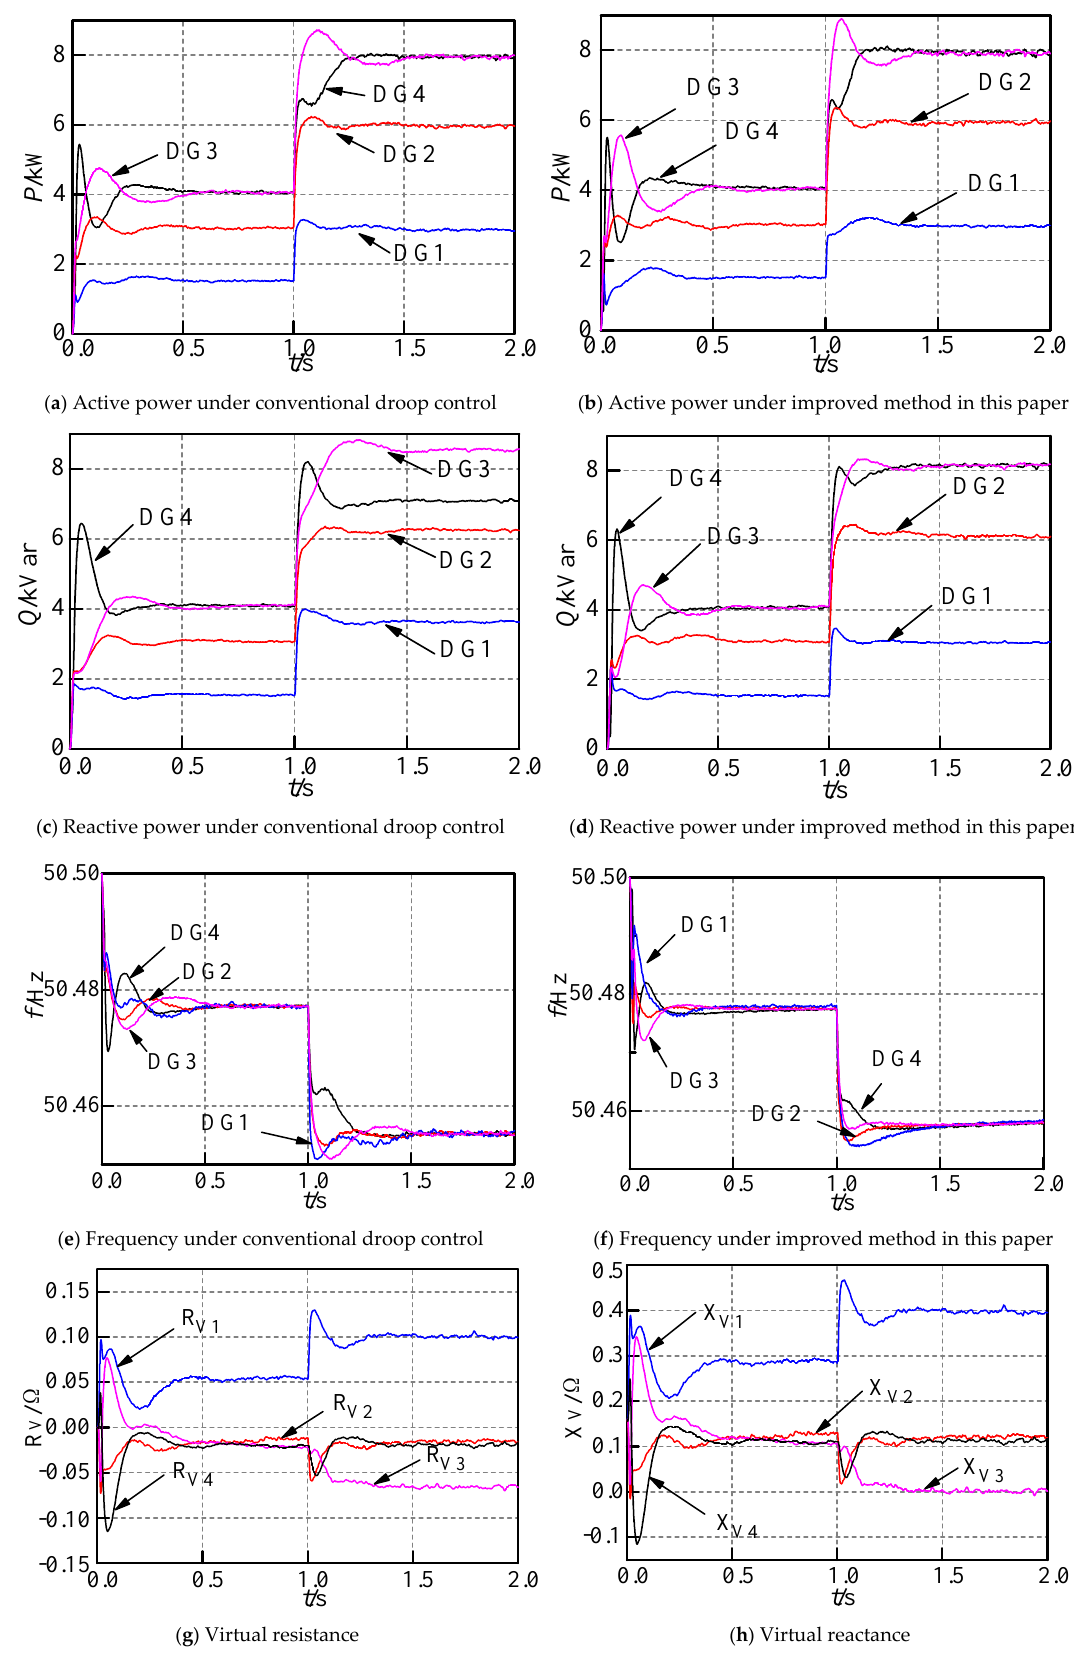
Figure 12. Performance comparison of the control strategy.